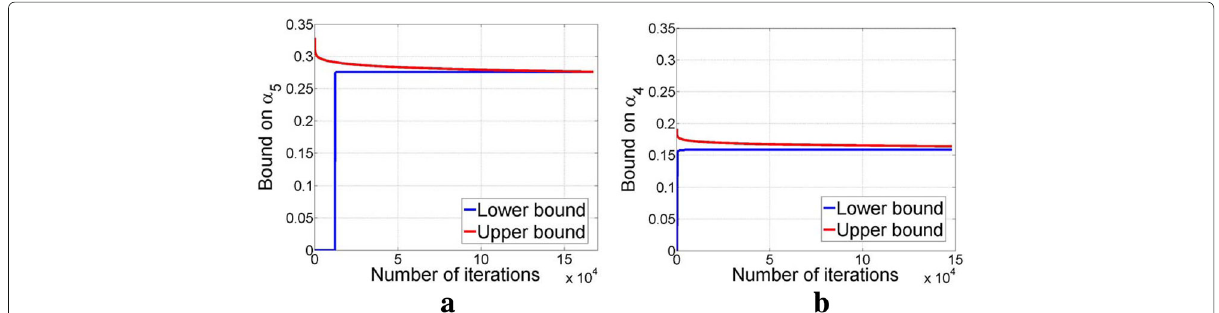
Fig. 6 Global lower bound (GLB) and global upper bound (GUB) in TSA on Gaussian sensing matrices. a For ( k , l ) = ( 5,3 ) , we obtained (GLB,GUB)=(0.27,0.28) after 167501 iterations. b For ( k , l ) = ( 4,2 ) , we obtained (GLB, GUB)=(0.15,0.17) after 148101